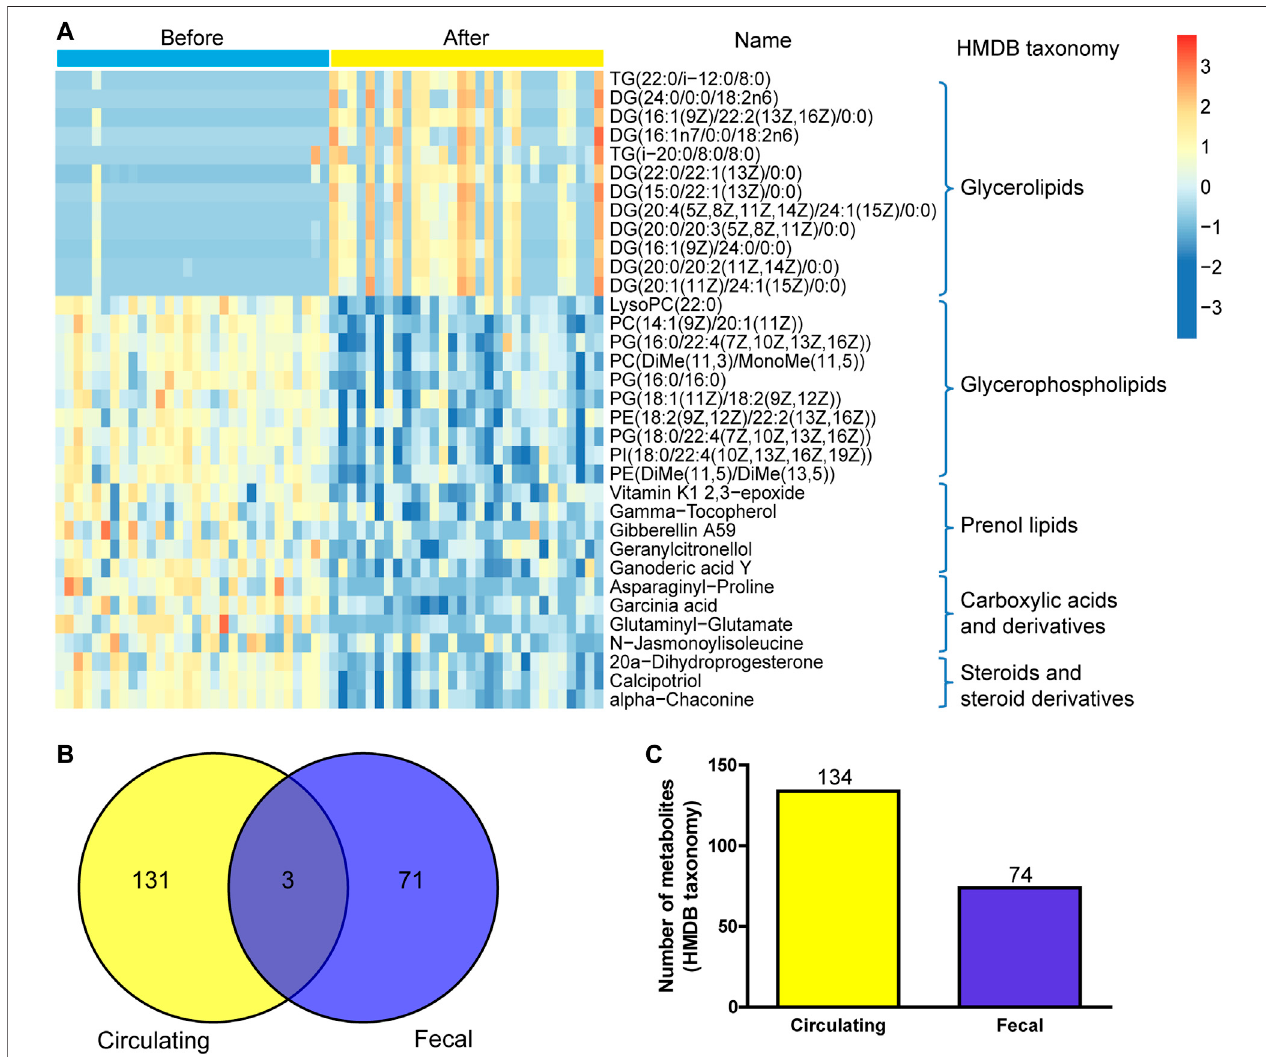
FIGURE7| Correlationanalysisoffecalmetabolitesandcirculatingmetabolites. (A) Hierarchicalclusteringanalysisforthefecalmetabolitesinthebefore-andafter- administration groups based on their z-normalized abundances. The name and HMDB taxonomy clusters of the metabolites were listed. (B) Venn and number (C) of HMDB taxonomy metabolite with differences in serum and fecal samples before and after administration.